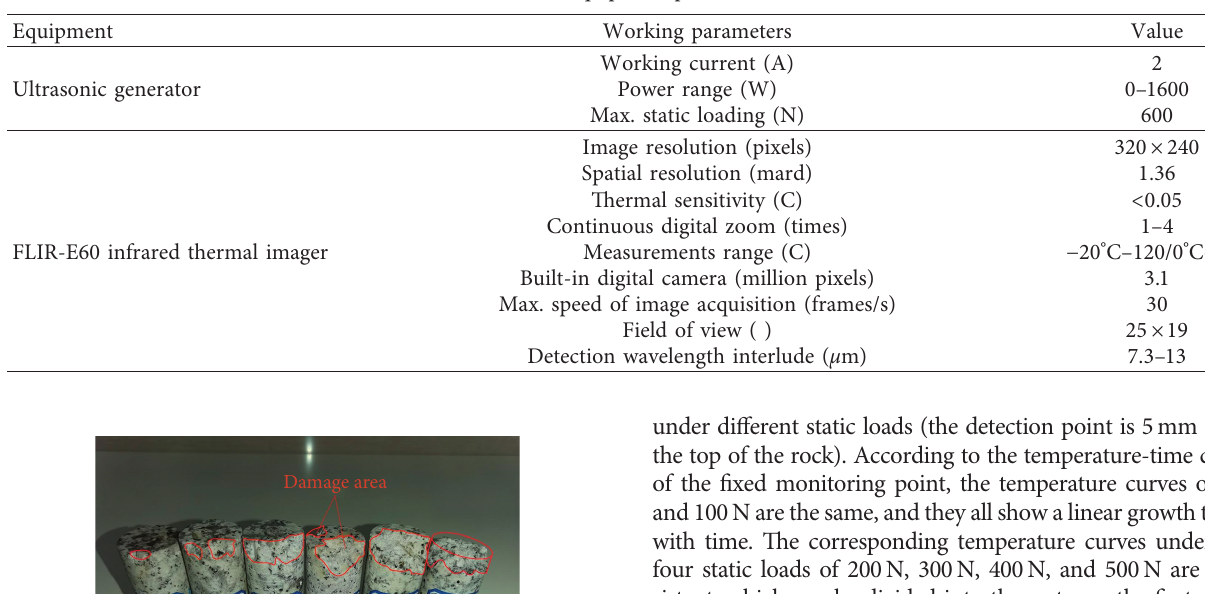
Table 4: Equipment